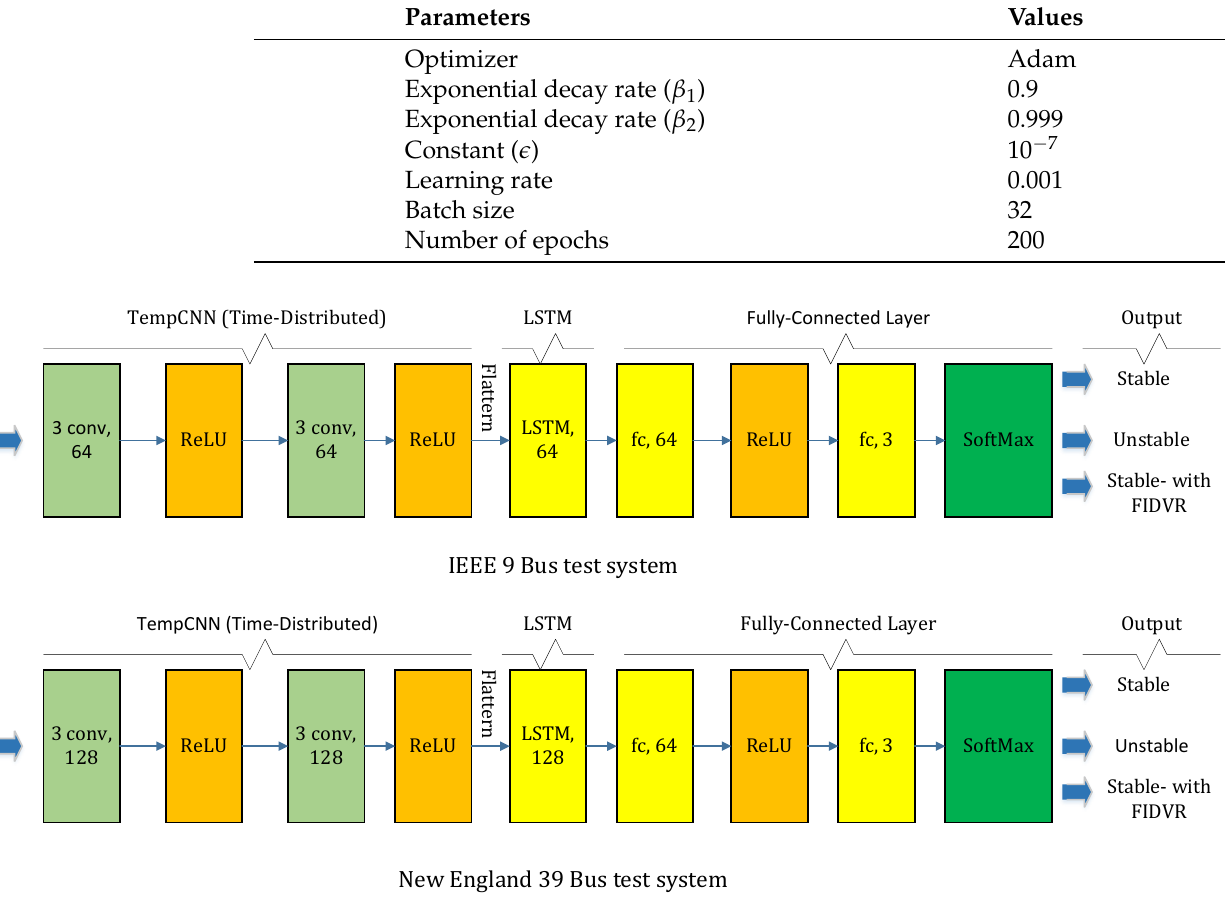
Figure 11. Architecture of the proposed TempCNN-LSTM model employed on test